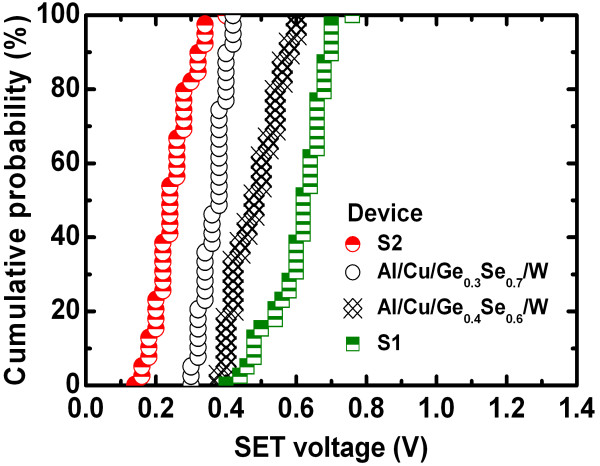
Cumulative probability of SET voltages for the S1 and S2 devices.